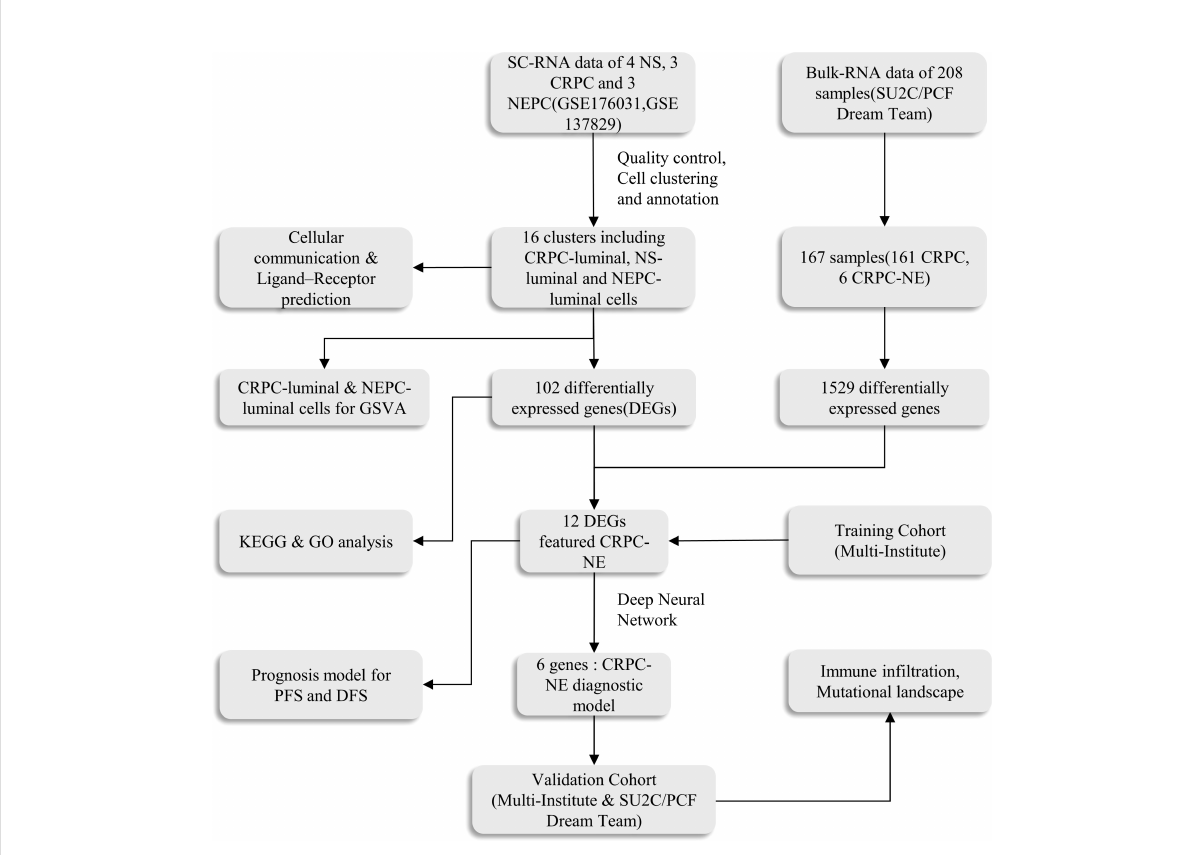
FIGURE 1 The main work fl ow of the study. SC-RNA, single-cell RNA; NS, normal sample; CRPC, castration-resistant prostate cancer; NEPC, Neuroendocrine prostate cancer;DEGs, differentially expressed genes; GSVA, Gene Set Variation Analysis; GO, Gene Ontology; KEGG, Kyoto Encyclopedia of Genes and Genomes; ROC, receiver operating characteristic; DFS, disease free survival; PFS, progression free